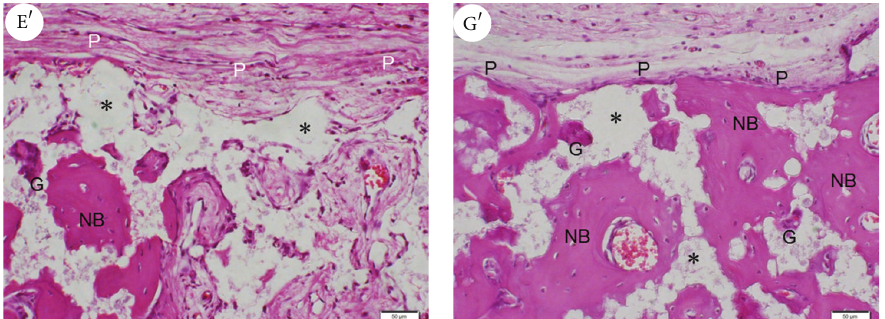
Figure 3: High magnification images of hematoxylin and eosin staining (E 󸀠 ) group E and (G 󸀠 ) group G. Note the obvious fibrous tissue and vessel formation in group E. In group G, newly formed bone is observed immediately below the periosteal layer and multinuclear giant cells are present. Original magnification 200x; scale bar = 50 𝜇 m. G: multinuclear giant cell; NB: newly formed bone; P: periosteal flap; ∗ remaining 𝛽